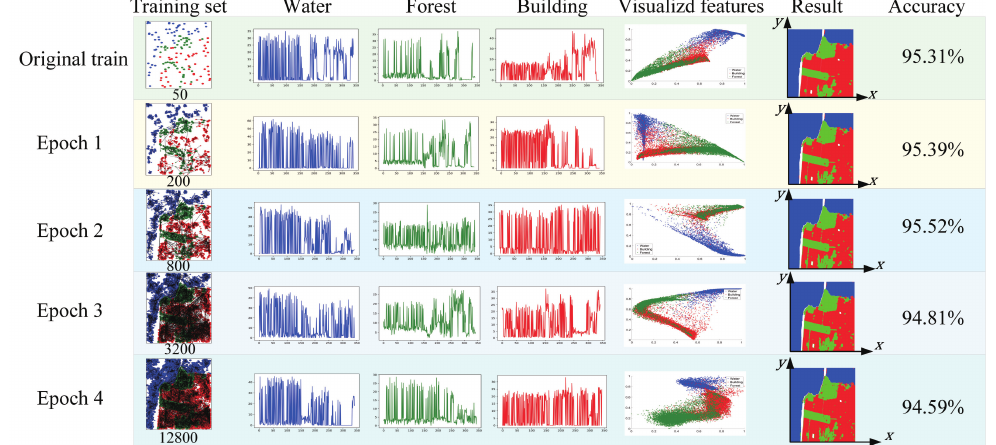
Figure 11. Training process and result of each selection loop on Rs2-Sanf. Training set, central vector of each land-cover category, visualization features of 342-D features vector visualized by t-SNE, classification result and